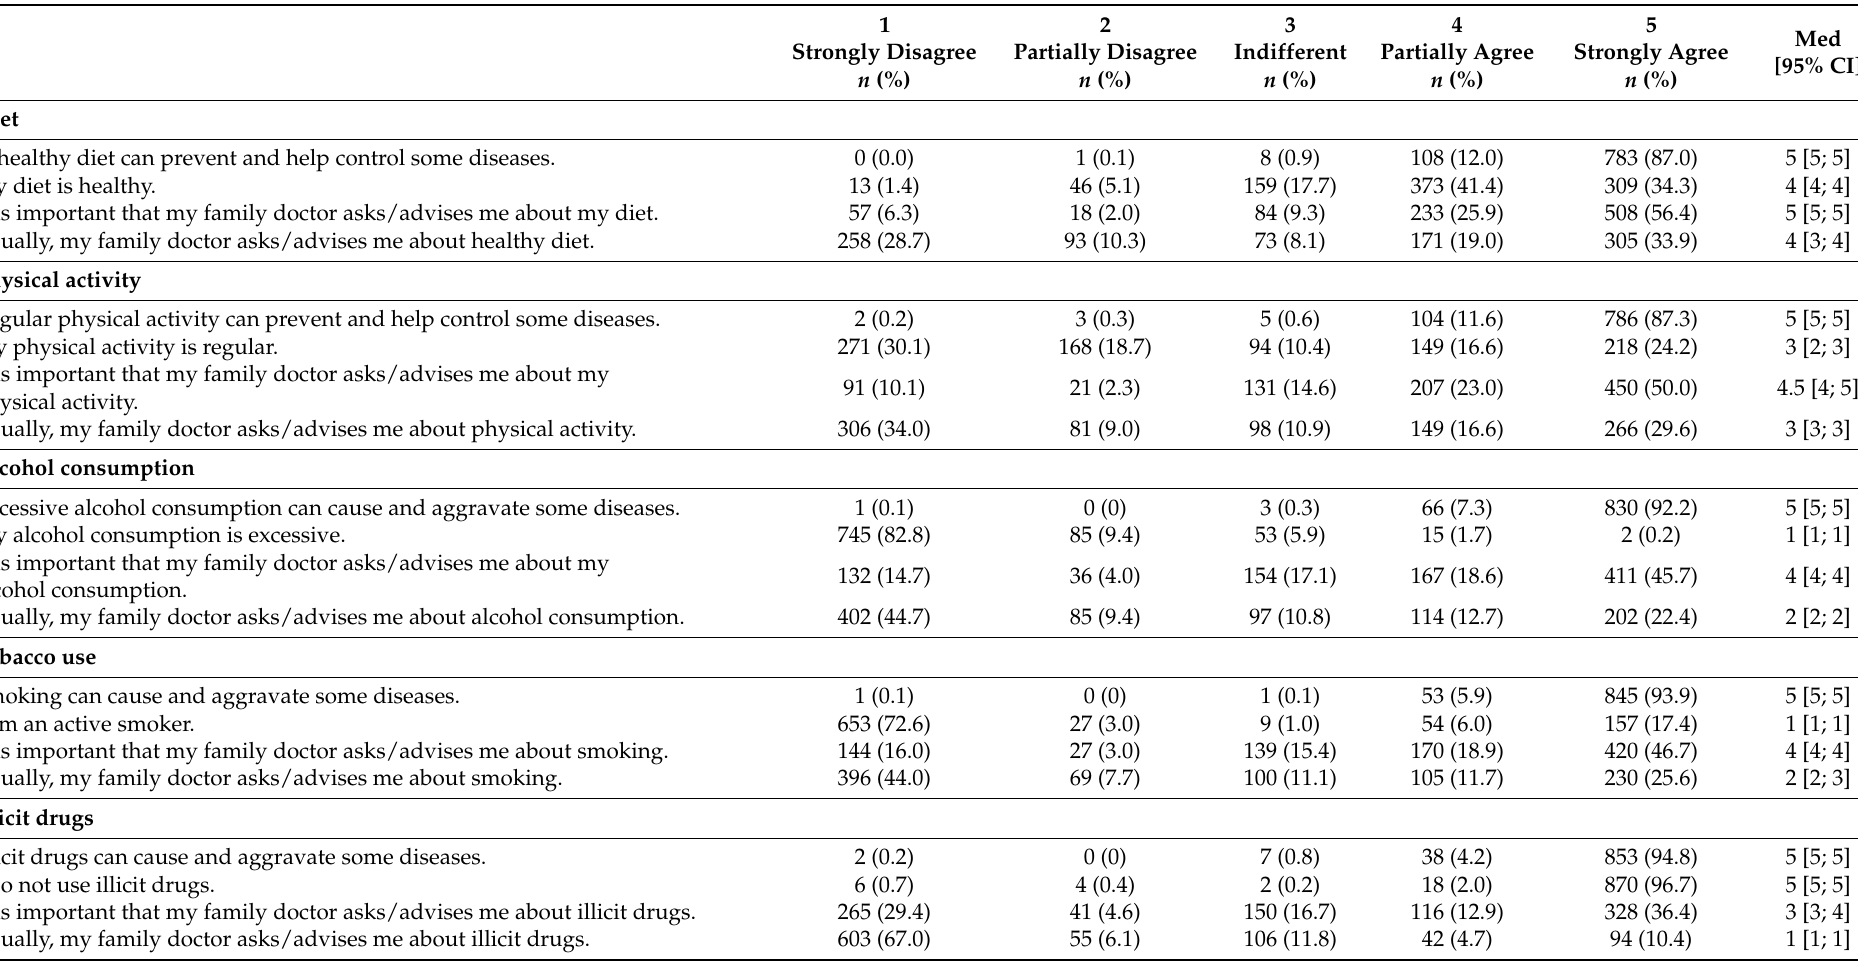
Table 3. Response distribution by the level of agreement with statements about lifestyle and lifestyle in the context of family